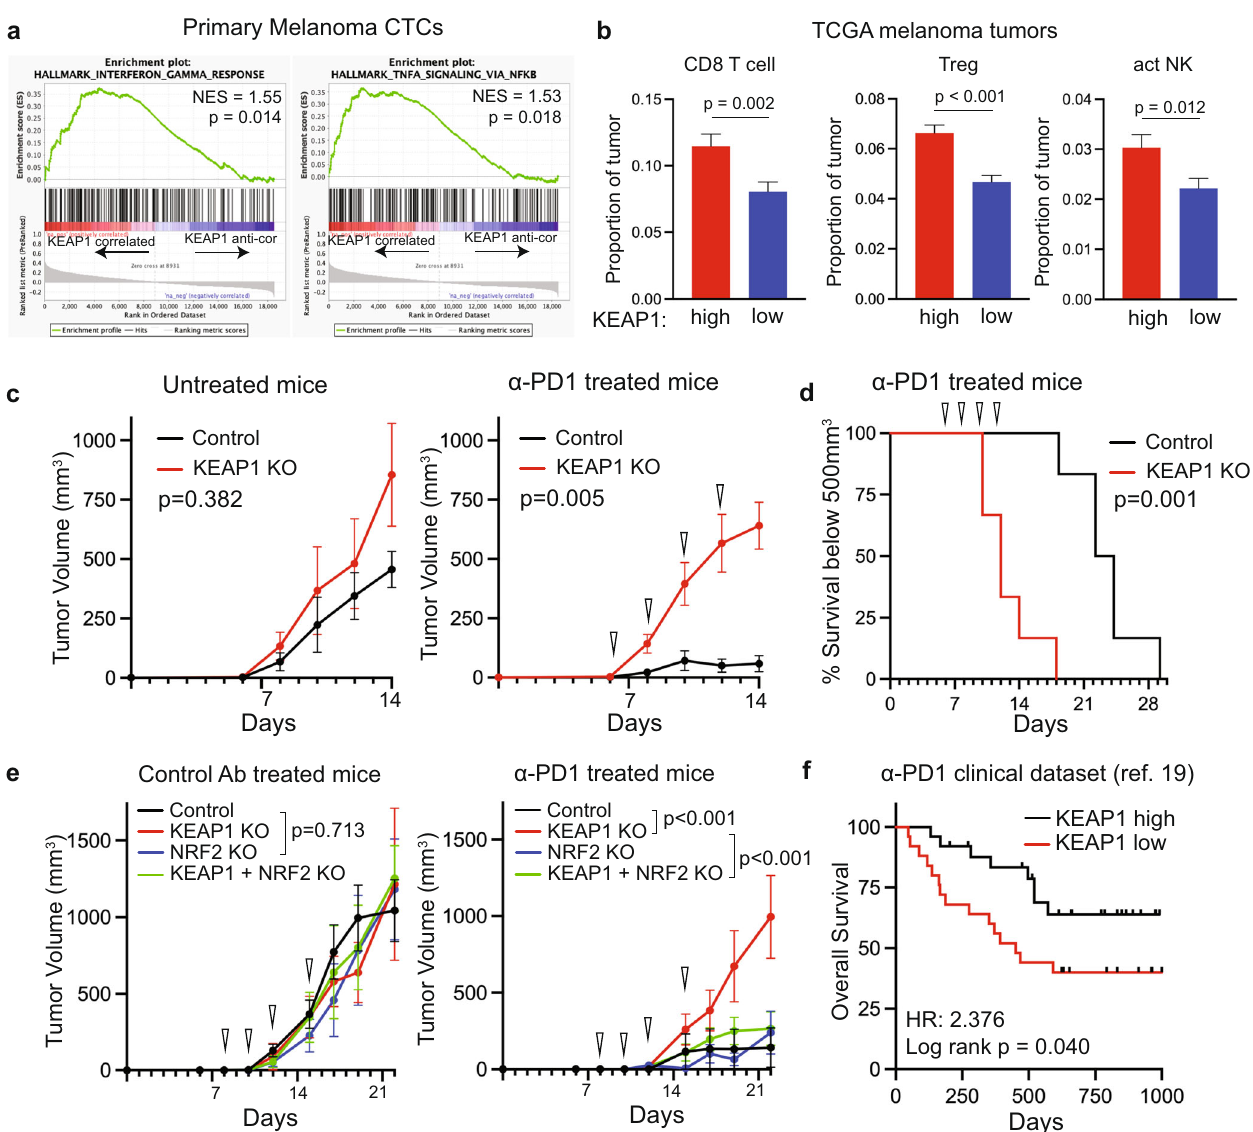
Fig. 2 KEAP1 loss induces resistance to anti-PD1 therapy. a GSEA plots showing enrichment for “ Hallmark Interferon Gamma Response ” and “ Hallmark TNFA Signaling via NFKB ” signatures correlated with KEAP1 expression in freshly isolated melanoma CTCs. b Plots showing abundance of CD8 T cells, Regulatory T cells (Treg), and activated natural killer cells (act NK) inferred by cibersort analysis in TCGA melanoma tumors with high (top third, n = 155) and low (bottom third, n = 155) KEAP1 mRNA expression. Signi fi cance determined by Student ’ s t test. c Tumor growth curves generated from control and KEAP1 knockout B16-OVA cells, treated with anti-PD1 antibody ( α -PD1) or untreated. Triangles denote days mice received treatment. Signi fi cance determined by two-way ANOVA ( n = 6 per condition). d Kaplan – Meier (KM) survival plot for anti-PD1 treated mice from panel c . Mouse survival is derived from sacri fi ce once tumors reached 500 mm 3 in size. Signi fi cance determined by log-rank (Mantel-Cox) test ( n = 6 per condition). e Tumor growth curves generated from control, KEAP1 knockout, NRF2 knockout, and KEAP1/NRF2 double knockout B16-OVA cells, treated with anti-PD1 antibody or matched isotype control antibody (control Ab). Triangles denote days mice received treatment. Signi fi cance determined by two-way ANOVA ( n = 6 per condition). f KM plot for overall survival for anti-PD1 treated melanoma patients with high (top third, n = 25) and low (bottom third, n = 25) KEAP1 mRNA expression in their tumors. Signi fi cance determined by log-rank (Mantel-Cox) test. Data derived from Liu et al. (ref. 19 ). Data are represented as mean ± Epigenetic changes in other KEAP1 regulatory sequences or cofactors, or changes in KEAP1 mRNA stability, are thus likely to drive heterogeneity of KEAP1 expression in melanoma. We next asked if KEAP1 expression is associated with